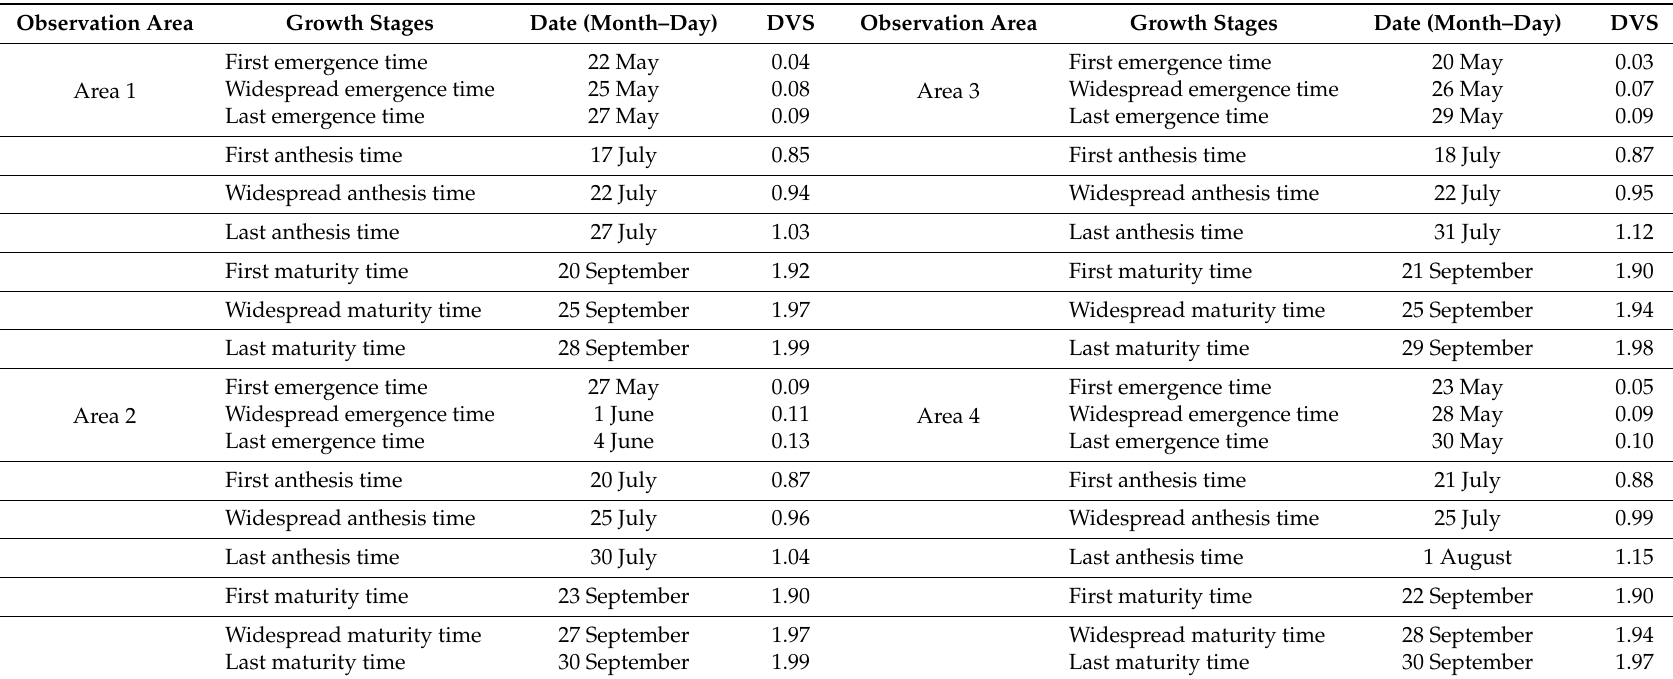
Table 1. Key growth stages of four observation areas in